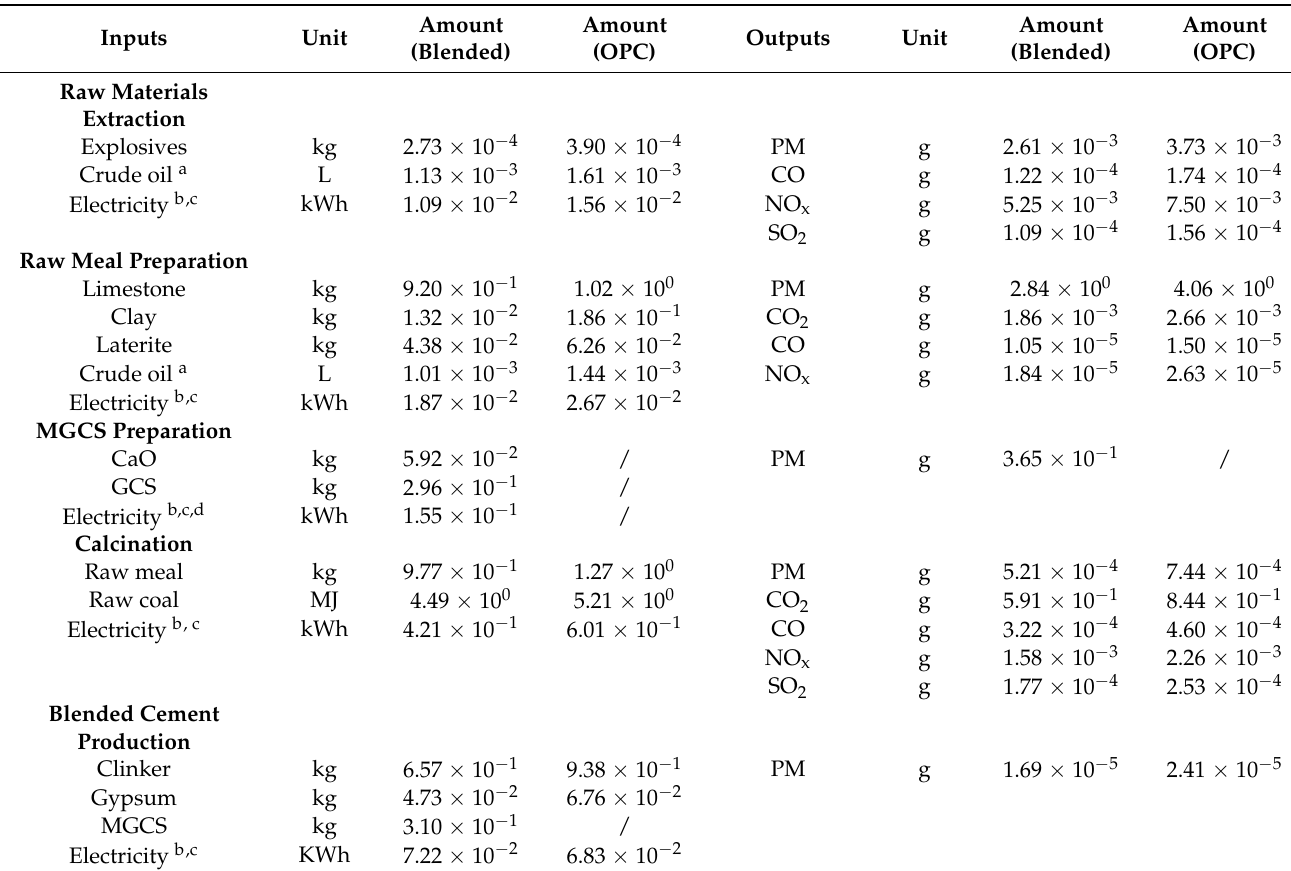
Table 1. Life cycle inventory of blended cement and OPC based on the defined